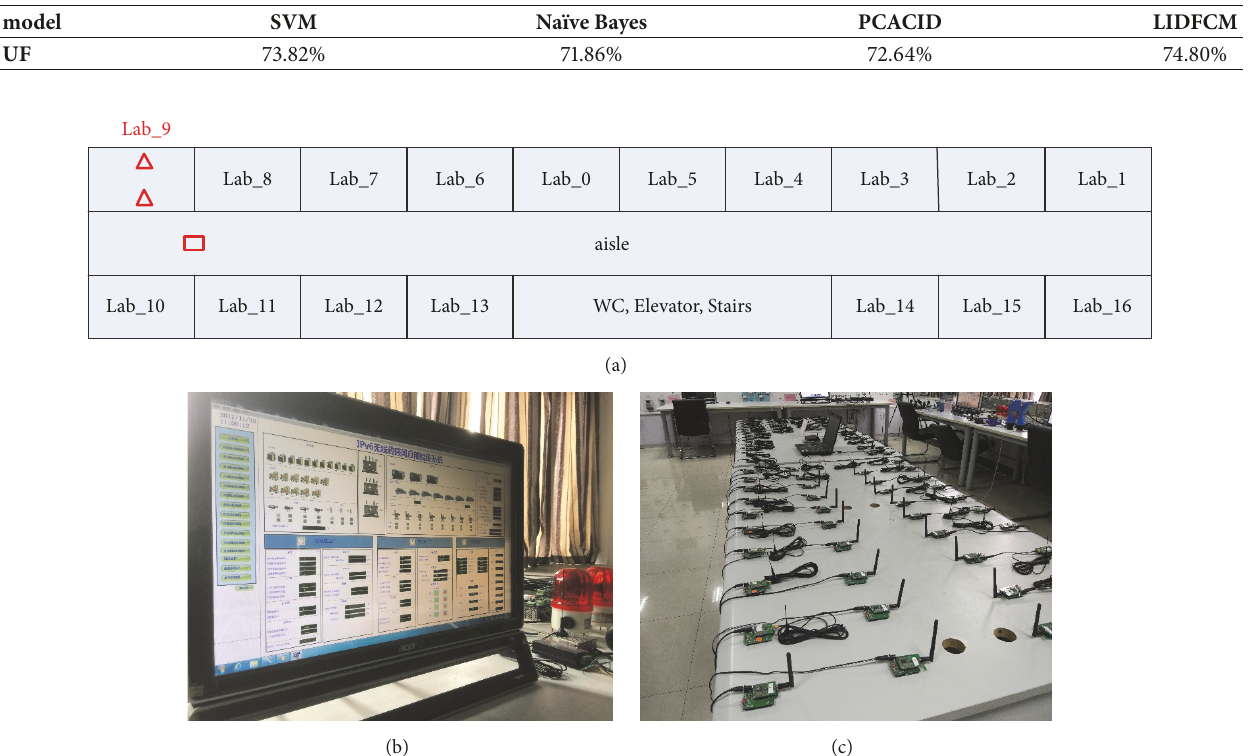
Figure 5: The IPv6-based wireless sensor network verification platform, where (a) is the deployment of the IPv6-based wireless sensor network verification platform, (b)isthemanagement interfaceof theverification platform, and (c)is an exhibition oftheverification